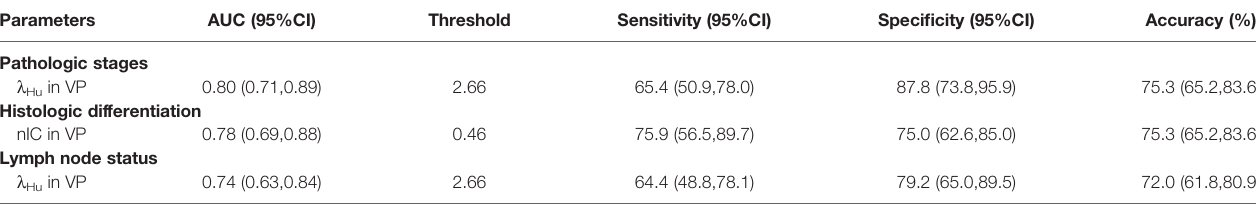
TABLE 4 | Receiver operating characteristic curve analysis of quantitative DECT parameters for discriminating the different aggressiveness of OTSCC.